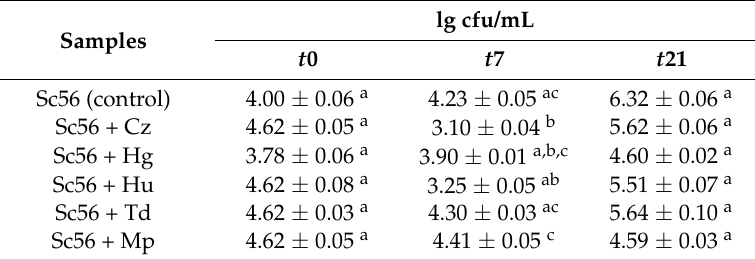
Table 6. B. bruxellensis Unifg 8 cell count (cfu/mL) on WLN agar medium from grape musts inoculated with different combinations of S. cerevisiae KT029756 with non- Saccharomyces strains ( Candida zemplinina KT029748, Hanseniaspora uvarum KT029770, Hanseniaspora guilliermondii KT029766, Torulaspora delbrueckii KT029800 and Metschnikowia pulcherrima KT029783) during AF: t 0, day of inoculation; t 7, 7 days from the inoculation; t 21, 21 days from the inoculation. Results of the ANOVA analysis are shown as letters on the data corresponding to the B. bruxellensis cell count: different letters on the same column indicate significant differences of 95%.